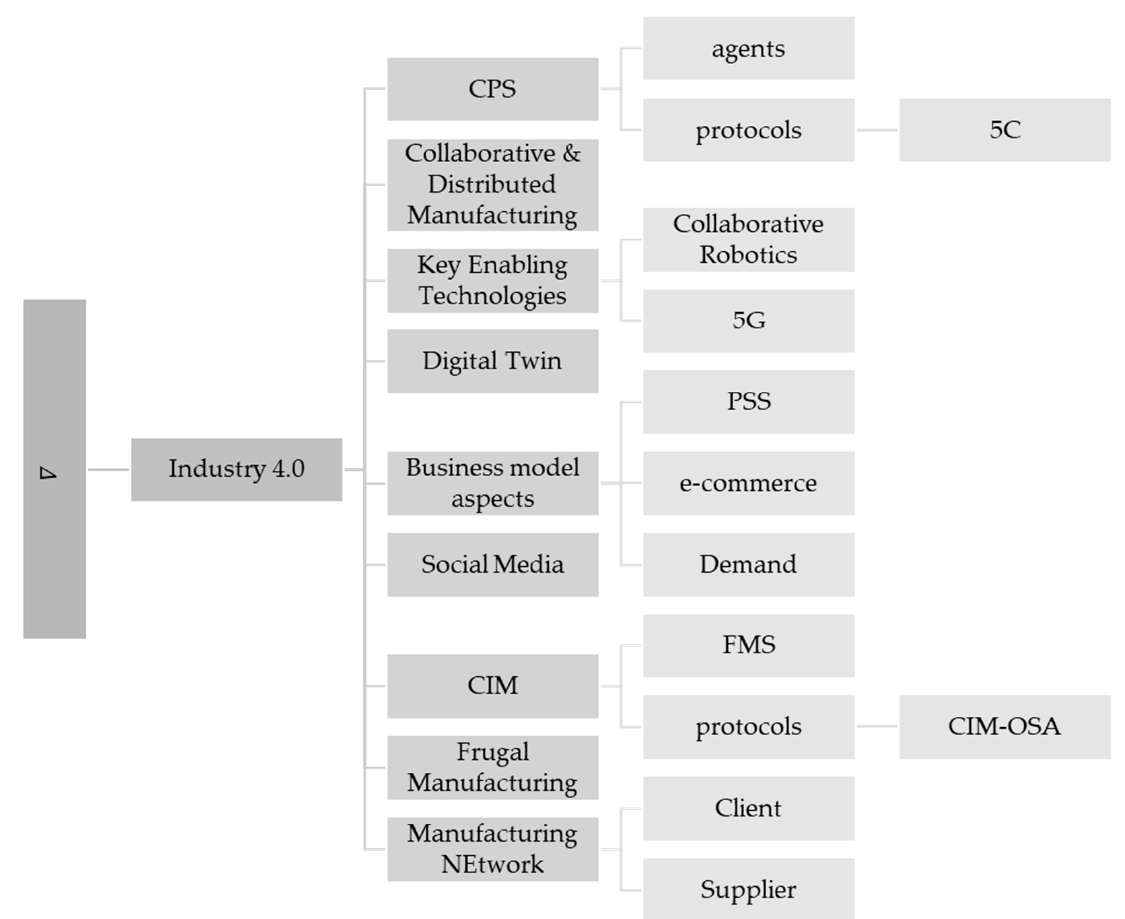
Figure A9. Technologies’ classification: Industry-4.0-related branch.